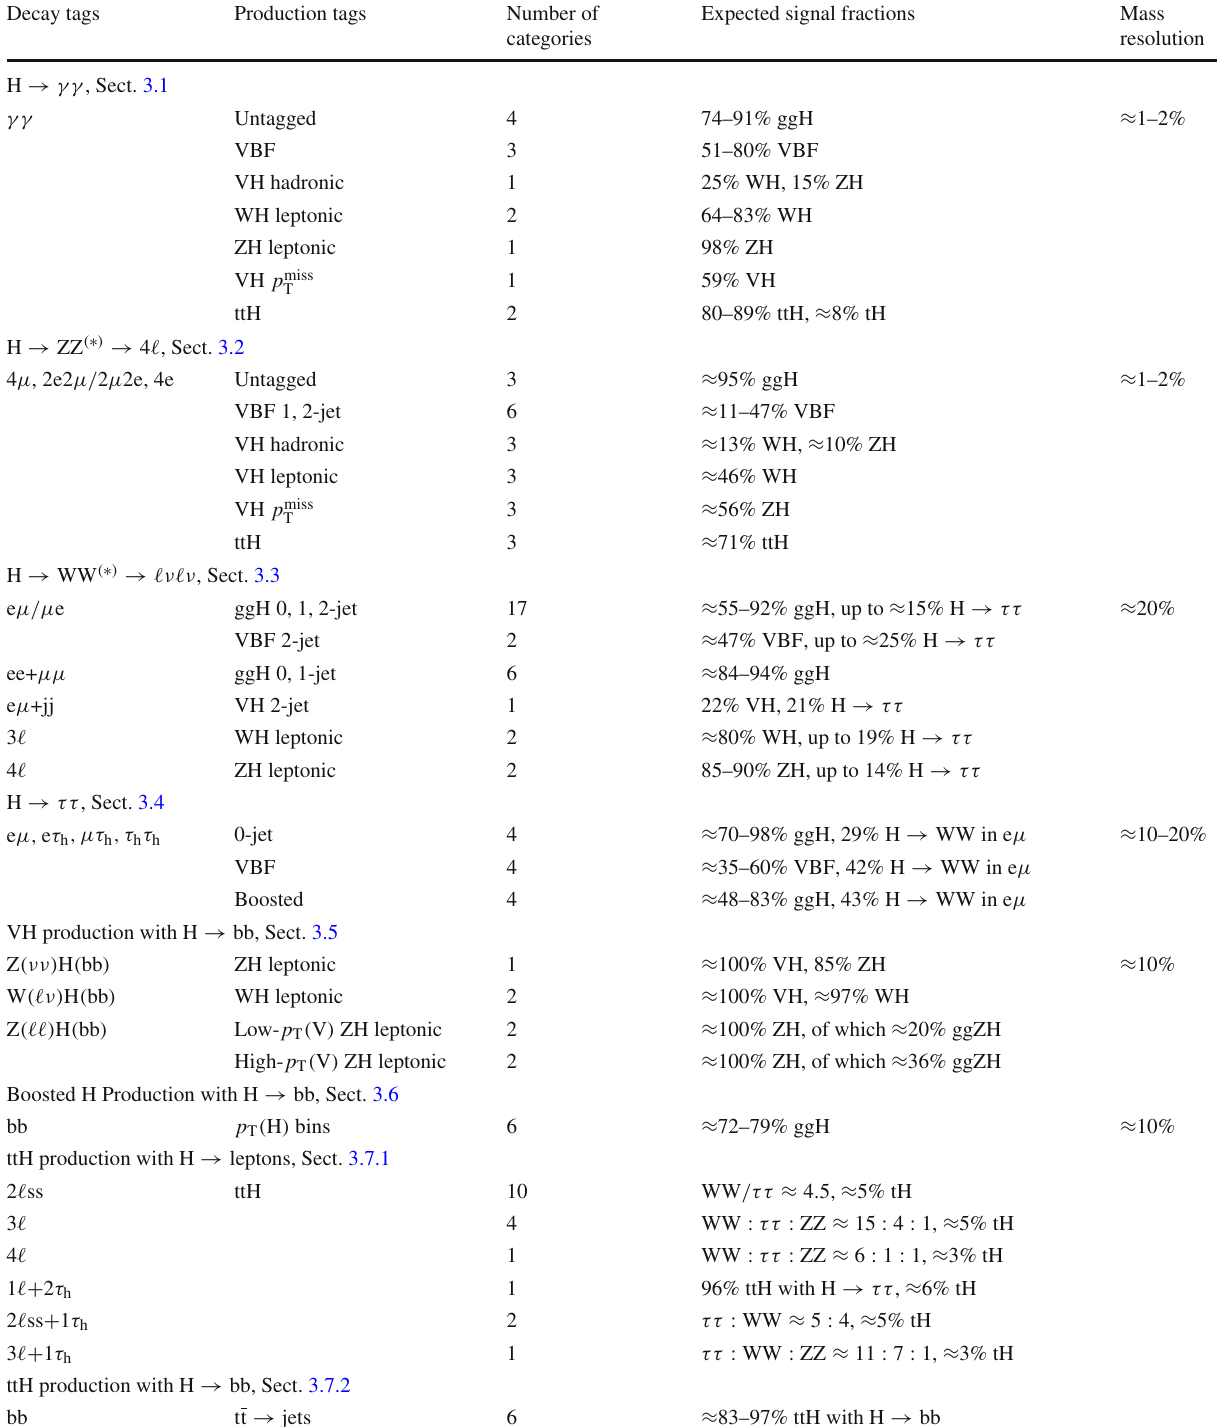
Table 1 Summary of the event categories in the analyses included in this combination. The first column indicates the decay channel and the secondcolumnindicatestheproductionmechanismtargetedbyananal- ysis. The third column provides the total number of categories per pro- duction tag, excluding control regions. Notes on the expected fractions ofdifferentHiggssignalproductionanddecaymodeswithrespecttothe